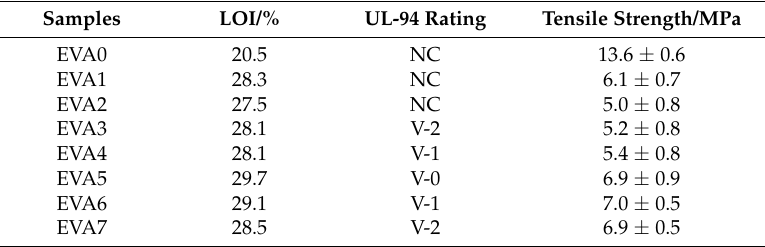
Table 3. Mechanical and flame-retardant properties of the EVA composites.